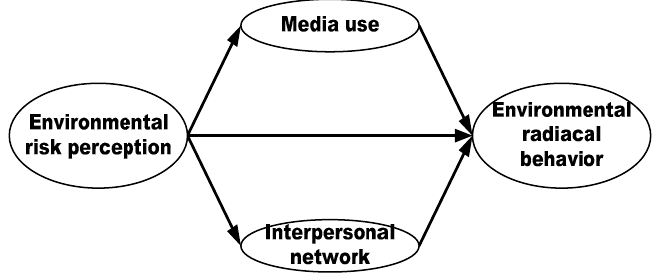
Figure 3. Risk transformation and diffusion path: from environmental risk perception to radical environmental behavior.